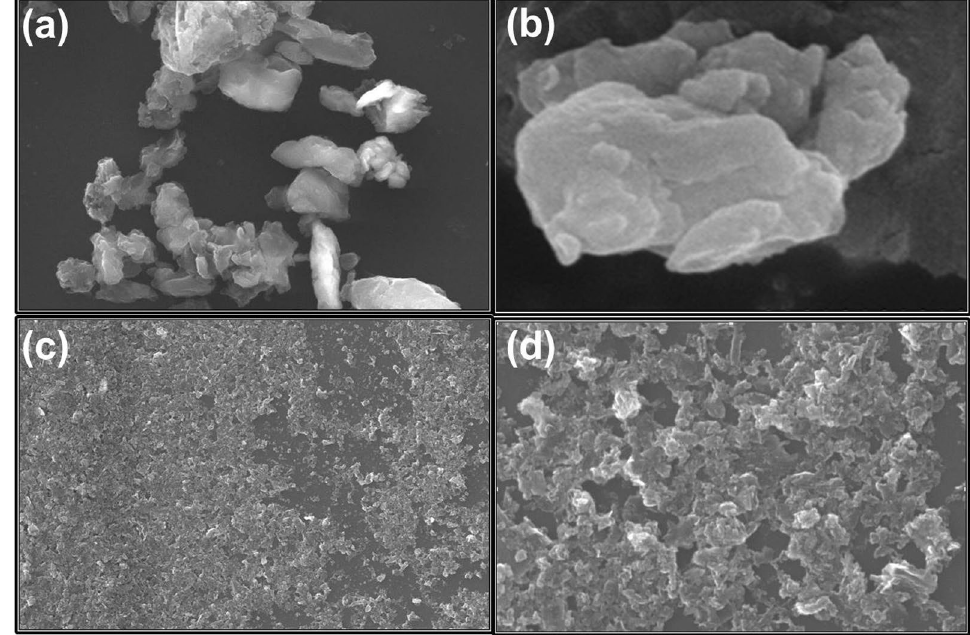
Fig. 4 SEM images of G‑C 3 N 4 ( a , b ), and T/ G‑C 3 N 4 ( c , d